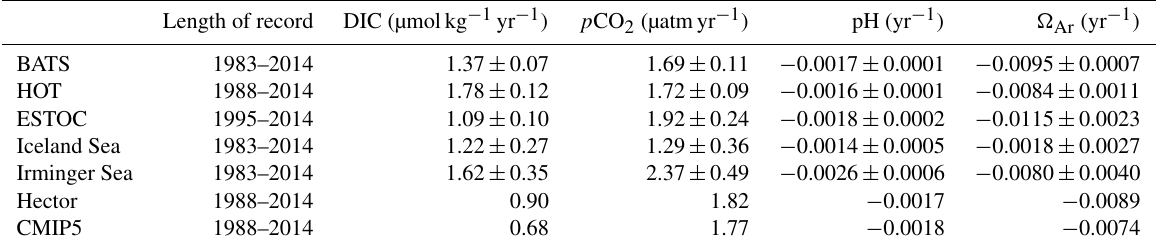
Table 6. Trends and standard error for the carbonate system taken from Bates et al. (2014) and values calculated from Hector and CMIP5. Length of record